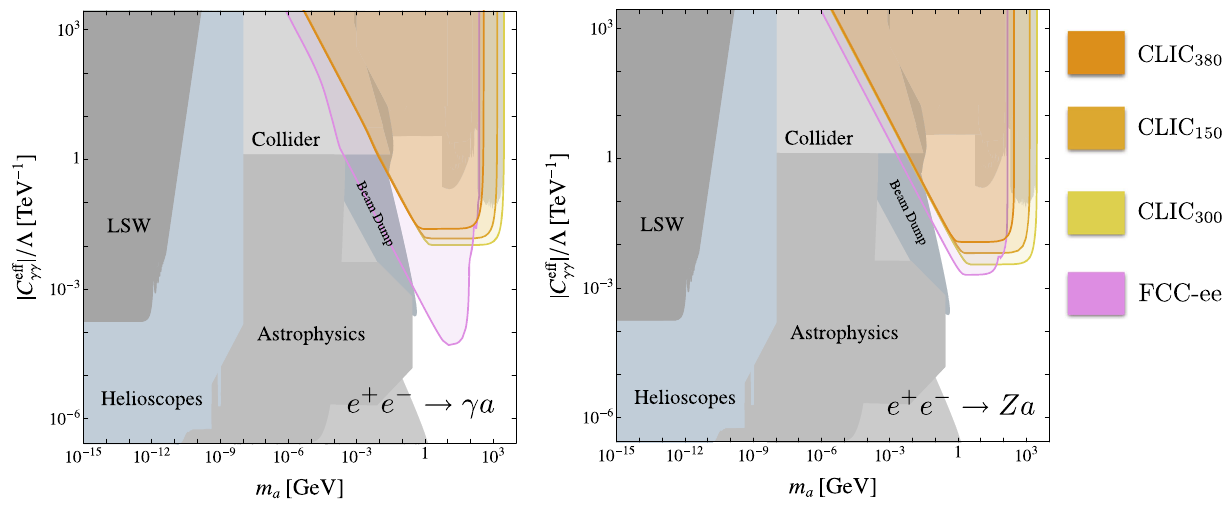
Fig. 6 Projected sensitivity regions for searches for e + e − → γ a → 3 γ (left) and e + e − → Za → Z vis γγ (right) at future e + e − colliders for Br ( a → γγ) = 1. The constraints from Fig. 4 are shown in the background. The sensitivity regions are based on 4 expected signal